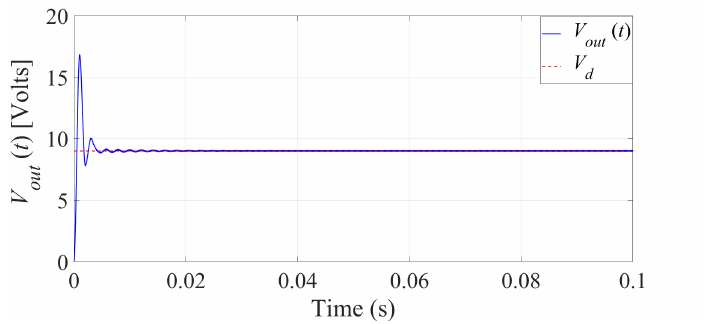
Figure 2. Output voltage ( V out ( t ) ) of the buck converter system with a constant input voltage ( V in ( t ) ).